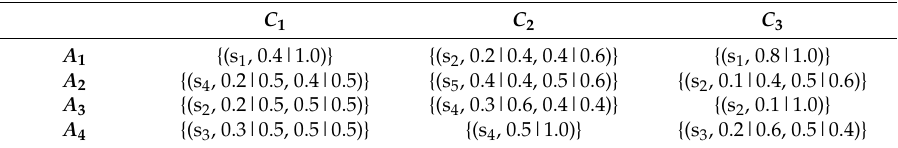
Table 2. HPFL decision matrix (cid:102) H 2 provided by D 2 .